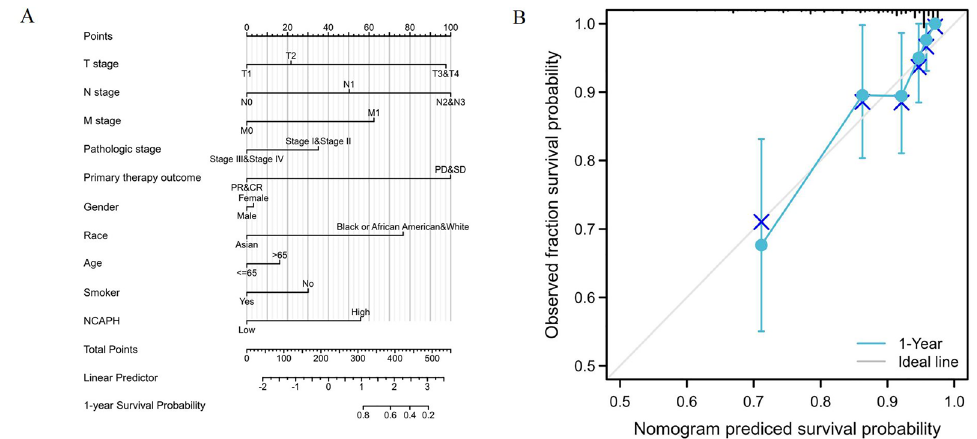
Figure 6. A quantitative method to predict LUAD patients’ probability of 1 year OS. ( A ) A nomogram for estimating the probability of 1 year OS for LUAD patients. ( B ) Calibration plots of the nomogram for evaluating the probability of OS at 1